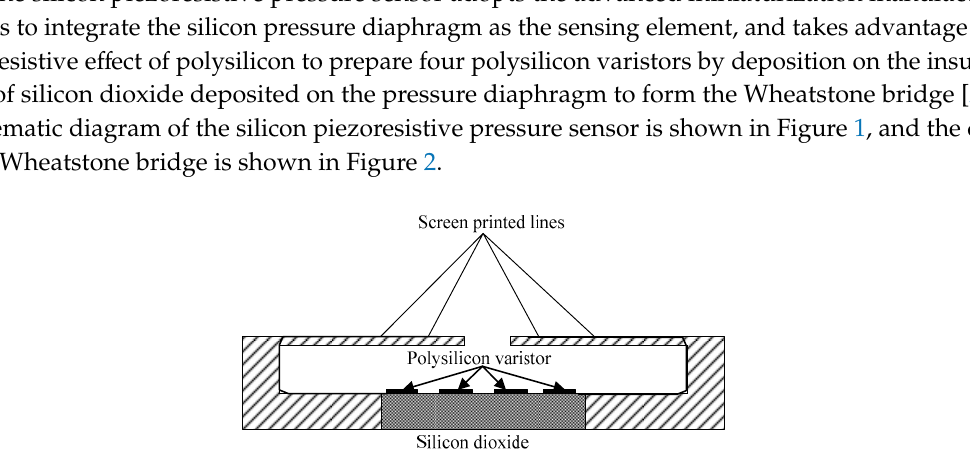
Figure 2. Wheatstone bridge circuit. In this paper, the Wheatstone bridge adopts a constant voltage source power supply. The pressure difference between the two sides of the silicon diaphragm makes the resistance value of the four resistors above also change. The Wheatstone bridge is out of balance, and the output voltage [24] is: